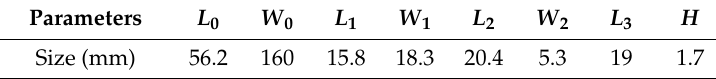
Figure 1. The configuration of the proposed antenna. Table 1. The size parameters of the proposed antenna.